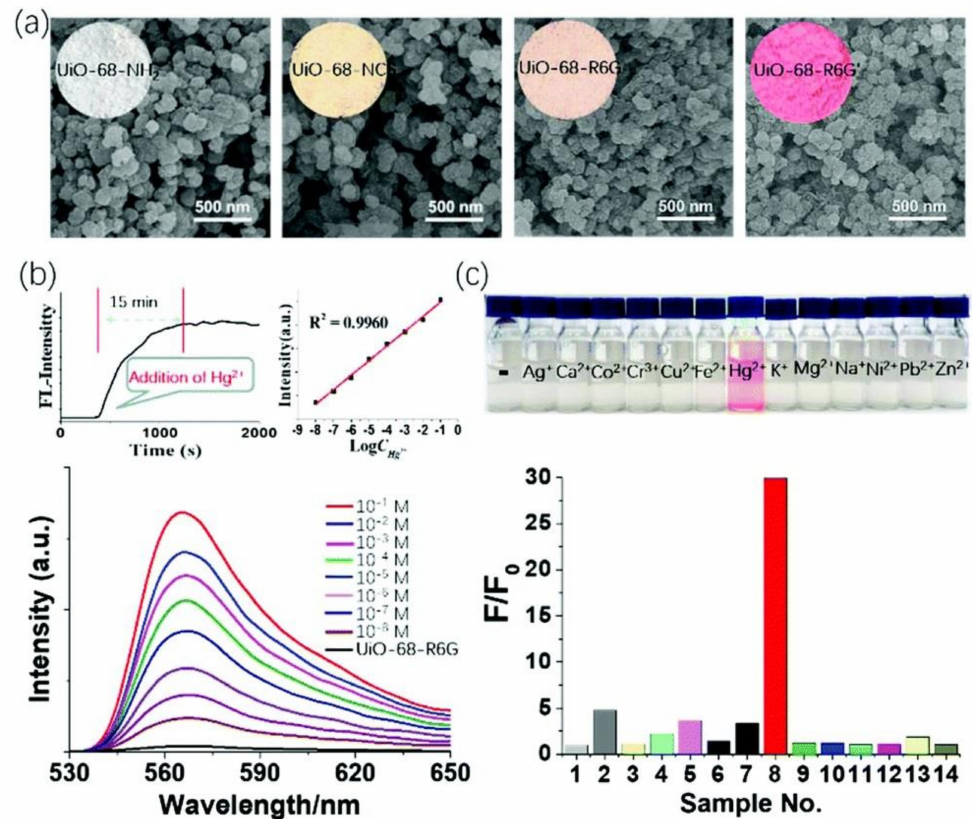
Figure 3. ( a ) SEM images of UIO-68-NH 2 , UIO-68-NCS , UIO-68-R6G , and UIO-68-R6G (cid:48) and their as-synthesized samples. ( b ) Emission spectra of UIO-68-R6G (0.1 mg mL − 1 ) upon the addition of Hg 2+ at different concentrations in the Tris-HCl buffer solution. K sv = 4.1 × 10 9 L mol − 1 . The emission maximum was observed at 566 nm ( λ ex = 488 nm). Linearity relationship between Hg 2+ with different concentrations and relative emission intensities, and the time-dependent emission of UIO-68-R6G with the sequential addition of Hg 2+ are shown in the insets. ( c ) Emission response of UIO-68-R6G toward various metal ions (10 − 4 M) in an aqueous solution (0.9 mL) of UIO-68-R6G (0.1 mg mL − 1 ): (1) blank, (2) Ag + , (3) Ca 2+ , (4) Co 2+ , (5) Cr 3+ , (6) Cu 2+ , (7) Fe 2+ , (8) Hg 2+ , (9) K + , (10) Mg 2+ , (11) Na + , (12) Ni 2+ , (13) Pb 2+ , and (14) Zn 2+ . The corresponding sample photographs are inserted (Reproduced with the permission from Ref